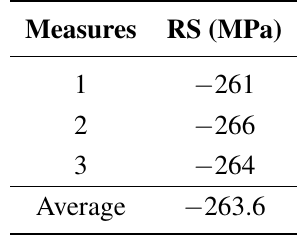
Table 3. Measurement of repeatability of the residual streses for run